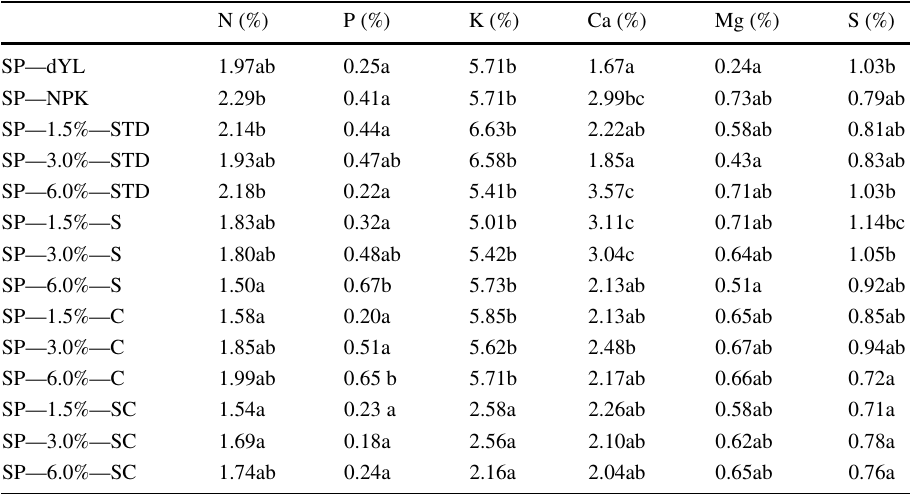
analysis (macronutrients) on sweet pepper leaves cultivated on different substrates (SP— STD, SP—S, SP—C and SP— SC), the reference sample (SP— NPK) and the control sample